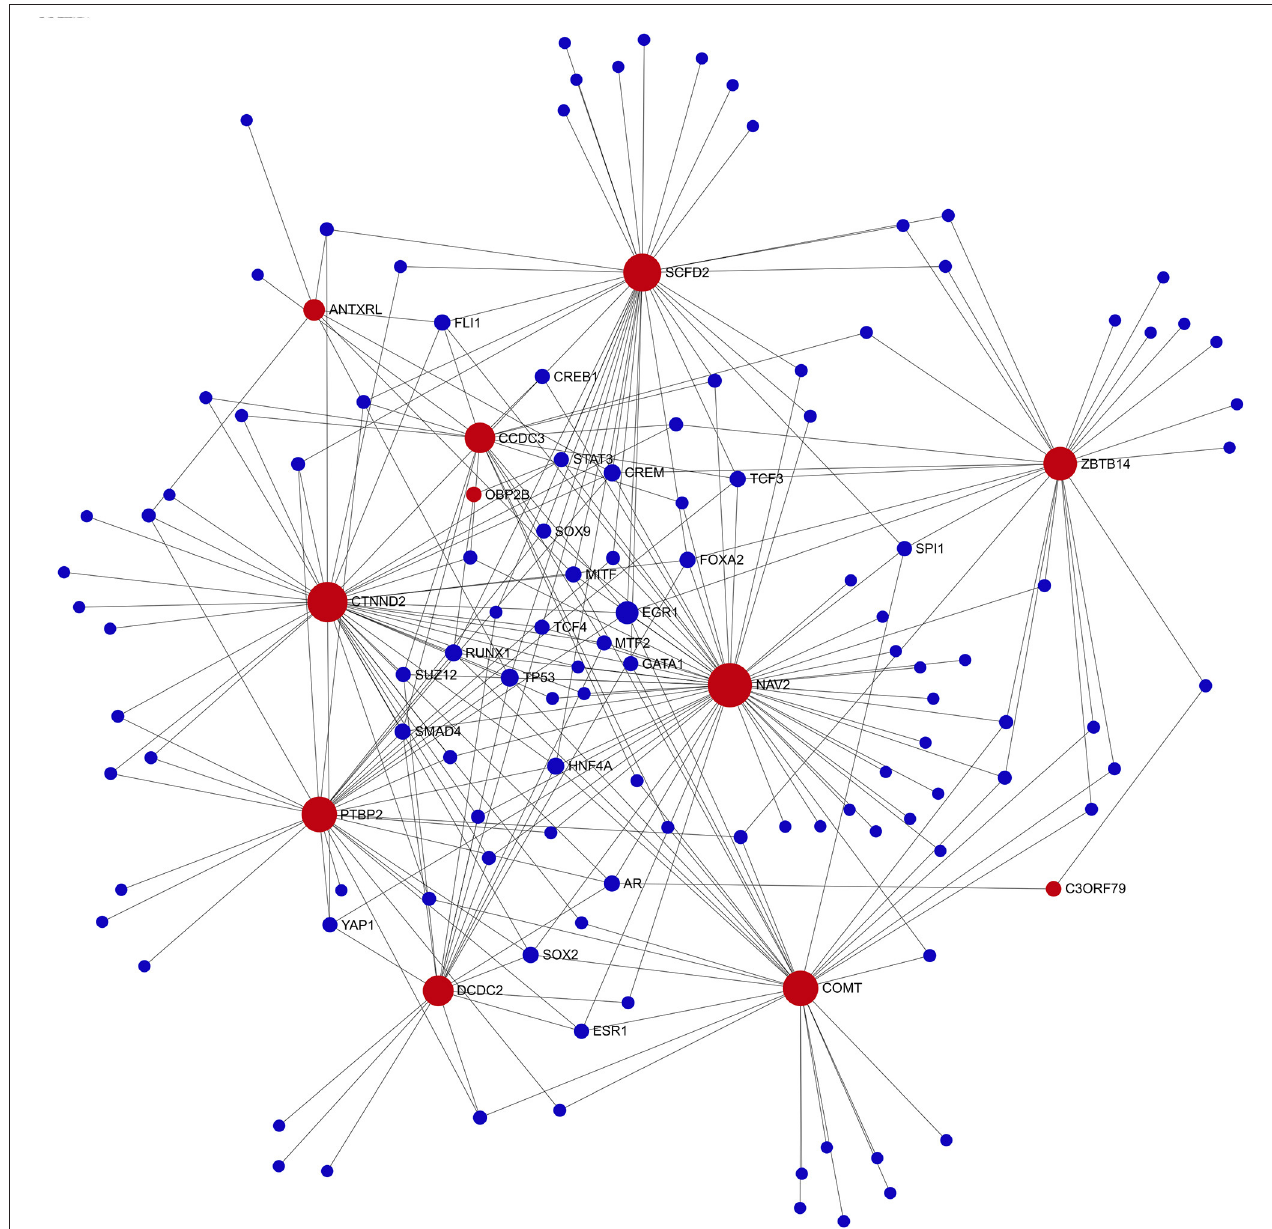
FIGURE 4 | Transcription factor network diagram consisting of seed genes (11-top genome-wide suggestive (red) genes and COMT ). Seed genes (red) with interaction partners (blue).